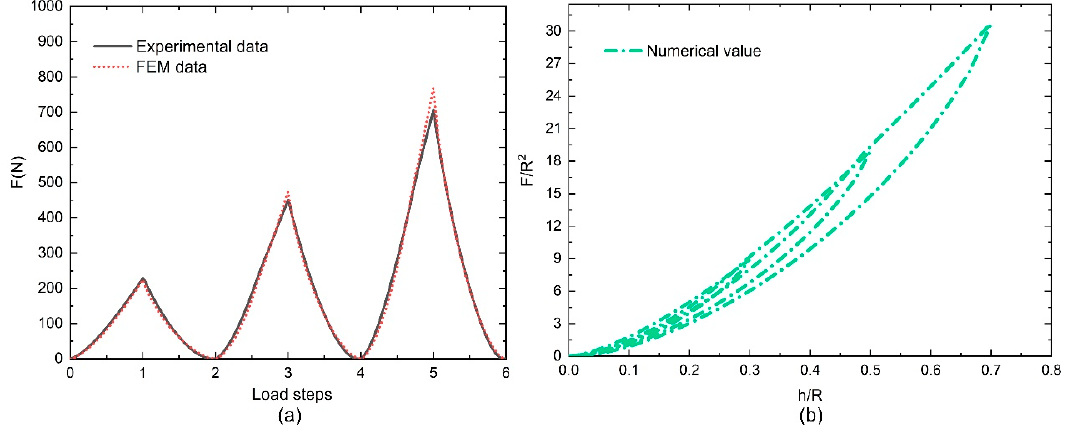
Figure 7. The numerical value curves for the unfilled polyurethanes (UFPUs) subjected to cyclic compressive load: ( a ) fitting the FEM data and the experimental data for the results of the loading steps; ( b ) numerical results of load-displacement curves. (FEM = finite element method).